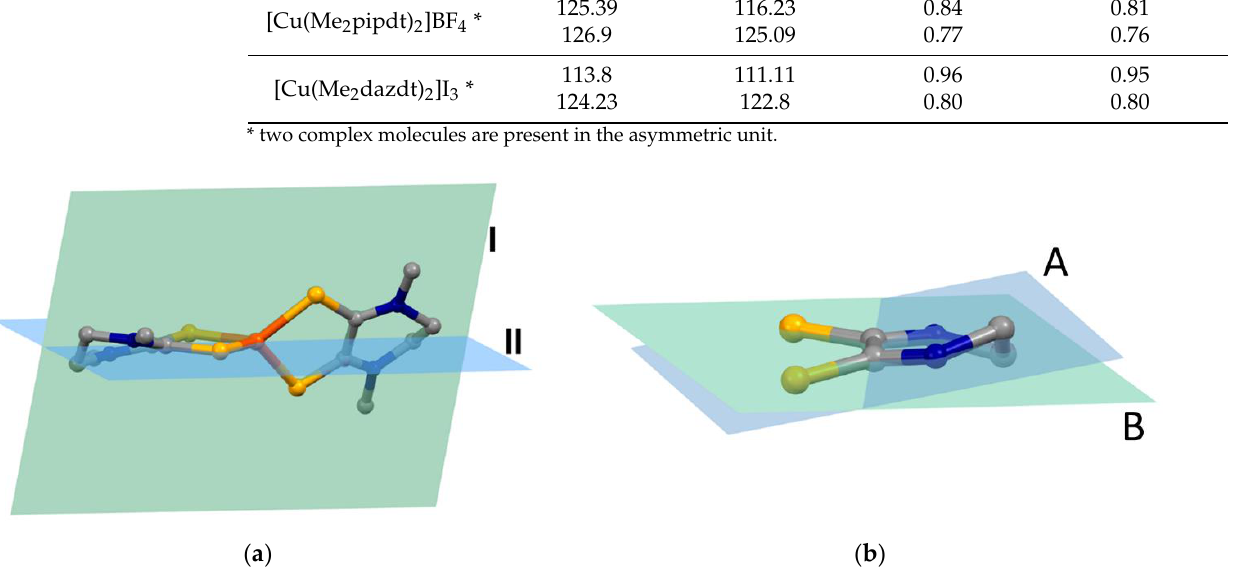
Figure 6. Depiction of the molecular planes used to calculate the dihedral angle between the S,S-chelate ligands ( a ) and between the thioamido groups ( b ). See also Tables S2 and S3.